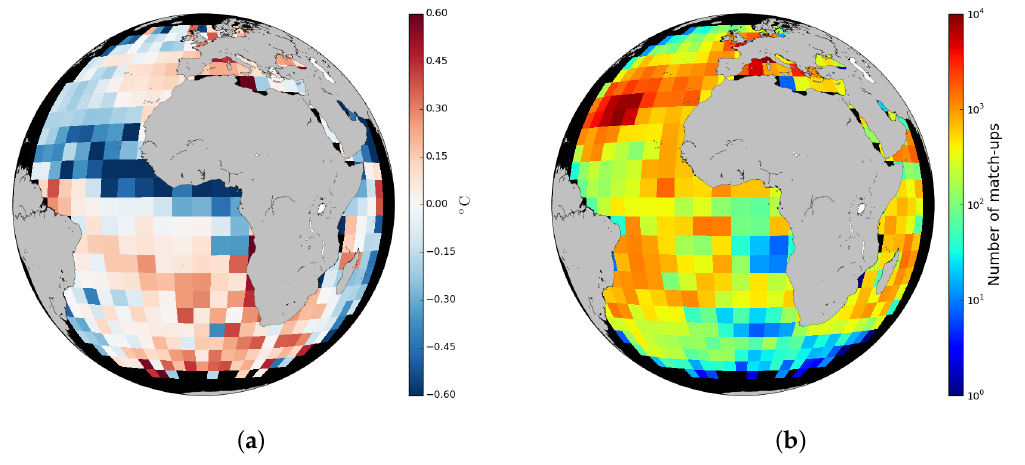
Figure 1. Training dataset (August 2013–July 2014, 249 318 match-ups): ( a ) mean difference between satellite and drifting buoys ( ∆ SST); ( b ) number of